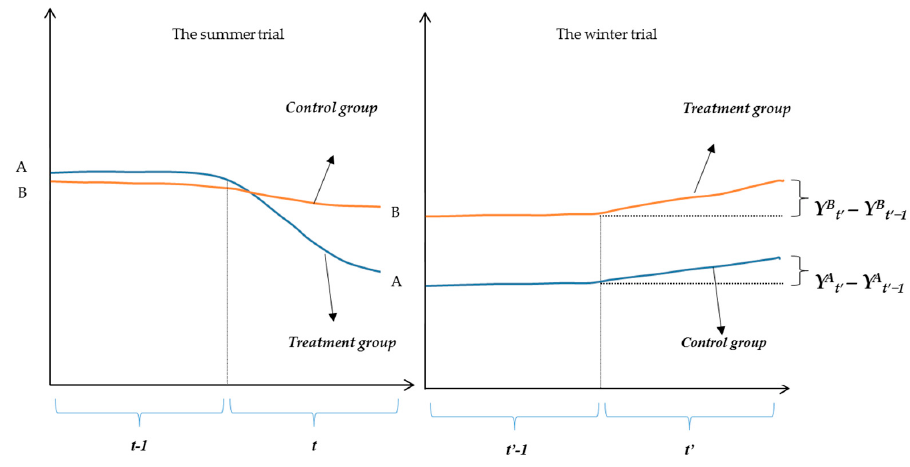
Figure 6. DID: Graphic depiction of treatment outcomes.